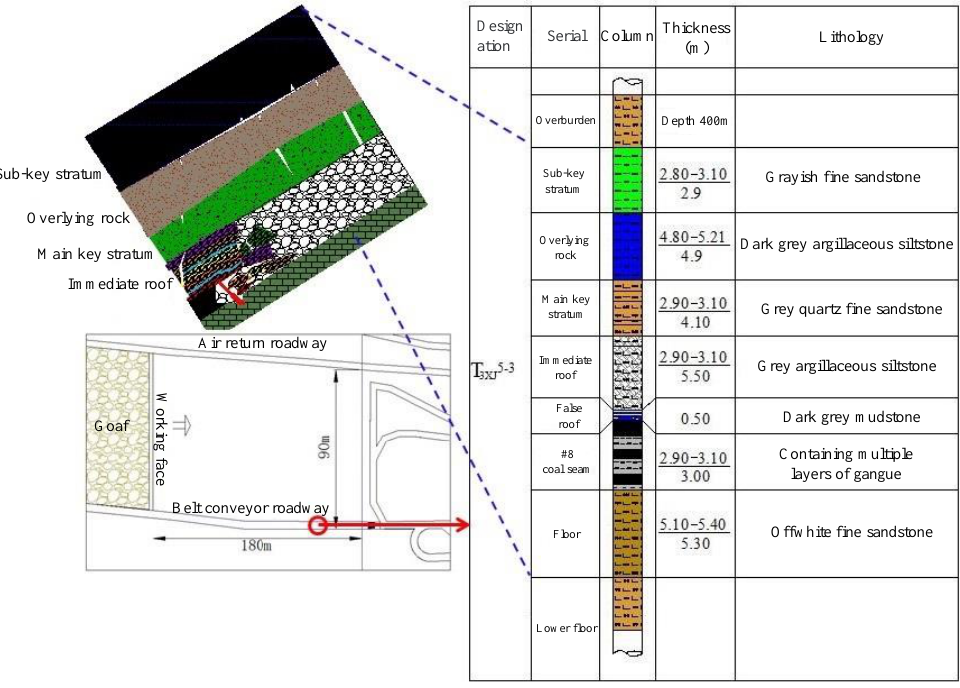
Figure 2. Layout of the eighth coal seam and lithostratigraphic column.